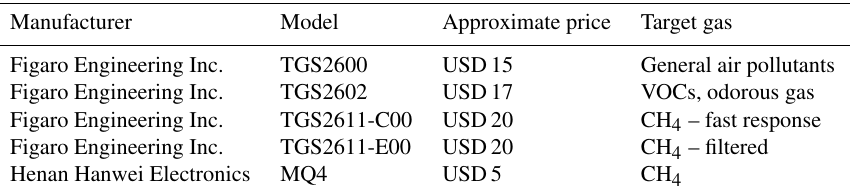
Table 2. Sensors used in this study. Prices for the Figaro sensors and MQ4 are from the distributors Maritex Co. and Pololu Corp., respectively, and were collected in November 2021. Manufacturer Model Approximate price Target gas Figaro Engineering Inc. TGS2600 USD15 General air pollutants Figaro Engineering Inc. TGS2602 USD17 VOCs, odorous gas Figaro Engineering Inc. TGS2611-C00 USD20 CH 4 – fast response Figaro Engineering Inc. TGS2611-E00 USD20 CH 4 – filtered Henan Hanwei Electronics MQ4 USD5 CH